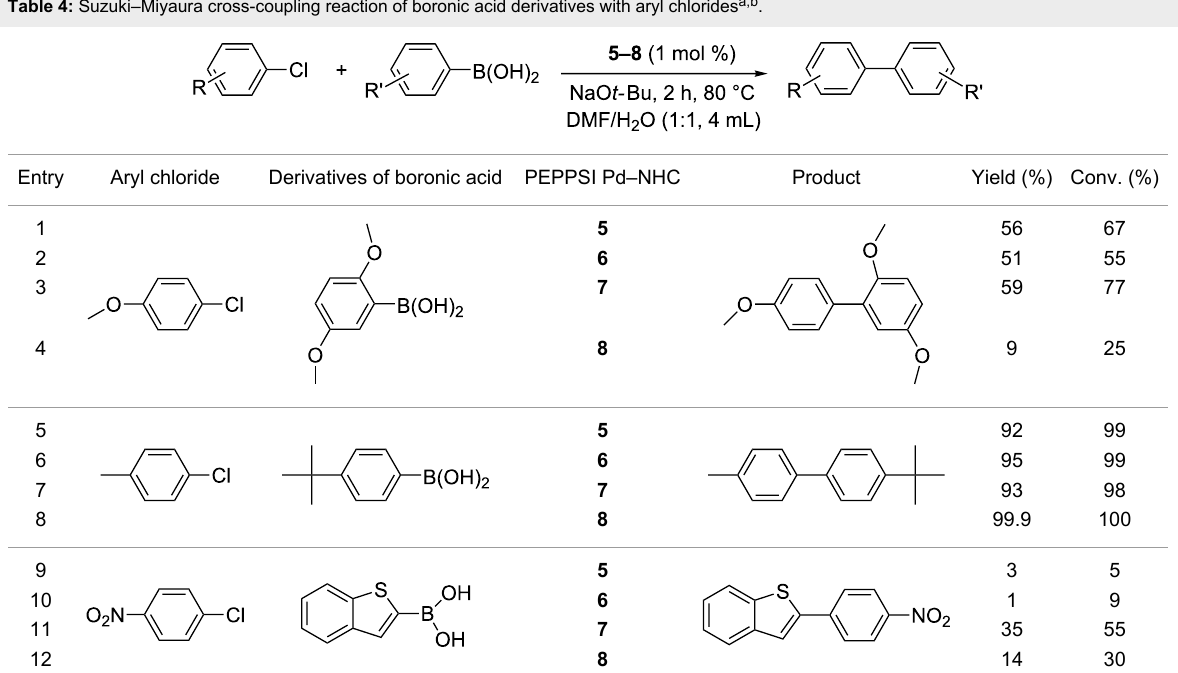
a Reaction conditions: 4-methoxy-1-chlorobenzene, 4-chlorotoluene, 4-chloronitrobenzene (1.0 mmol), 2,5-dimethoxyphenylboronic acid, 4- tert - butylphenylboronic acid, thianaphthene-2-boronic acid (1.5 mmol), NaO t -Bu (2.0 mmol), 5–8 (1 mol %), DMF/H 2 O (1:1, 4 mL), 80 °C, 2 h. b Yields were calculated according to aryl chlorides by using GC or